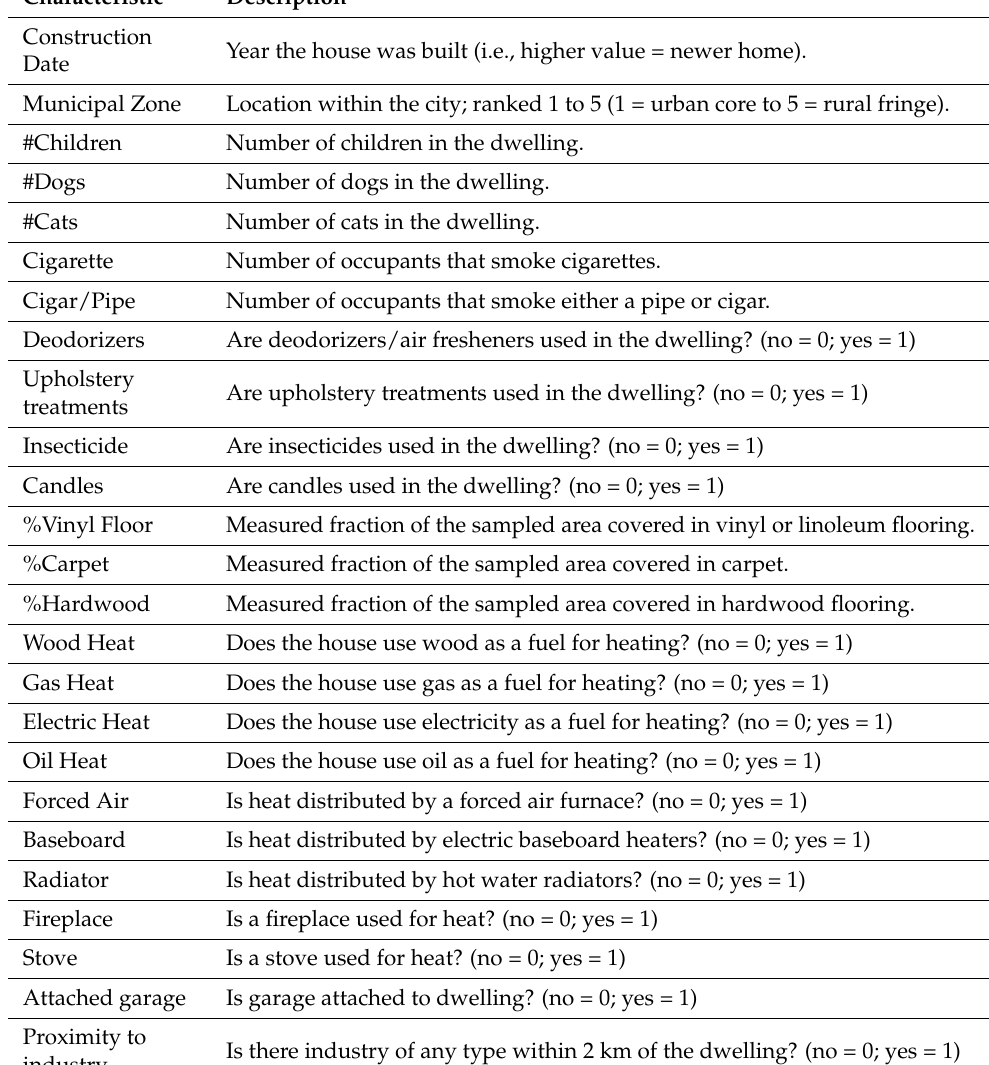
Table 1. Characteristics of Canadian House Dust Study homes discussed in paper (either measured or captured by administering questionnaire during home visit). Numerical coding is indicated for yes/no and ranked